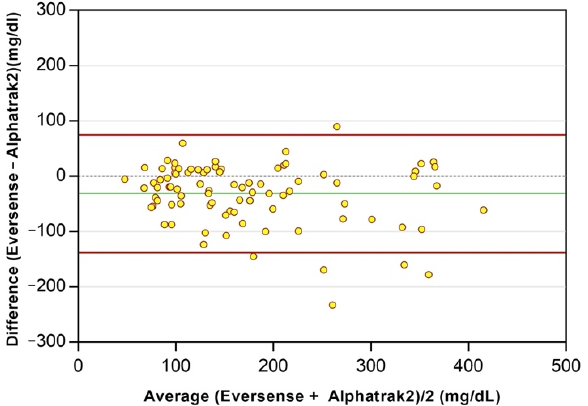
Table 2. Eversense’s analytical accuracy in the low (BG < 100 mg/dL) and high glucose range (BG ≥ 100 mg/dL).